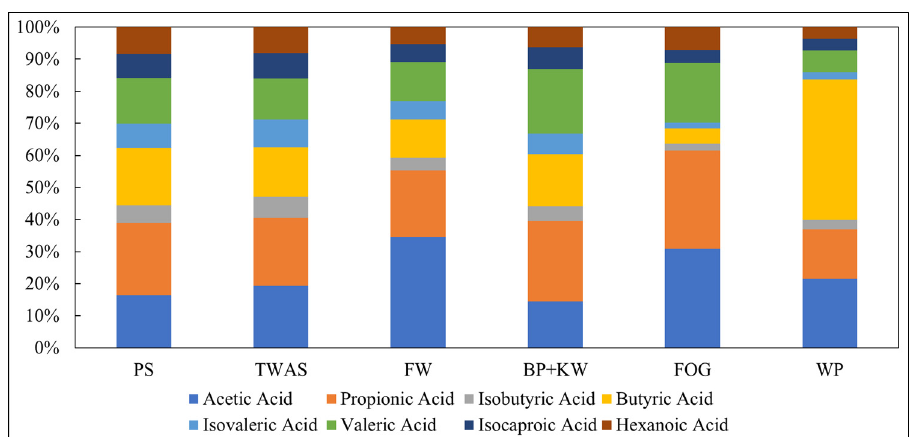
Figure 3. VFA composition fractions produced in the fermentation of PS, TWAS, FW, BP+KW, FOG, and WP.